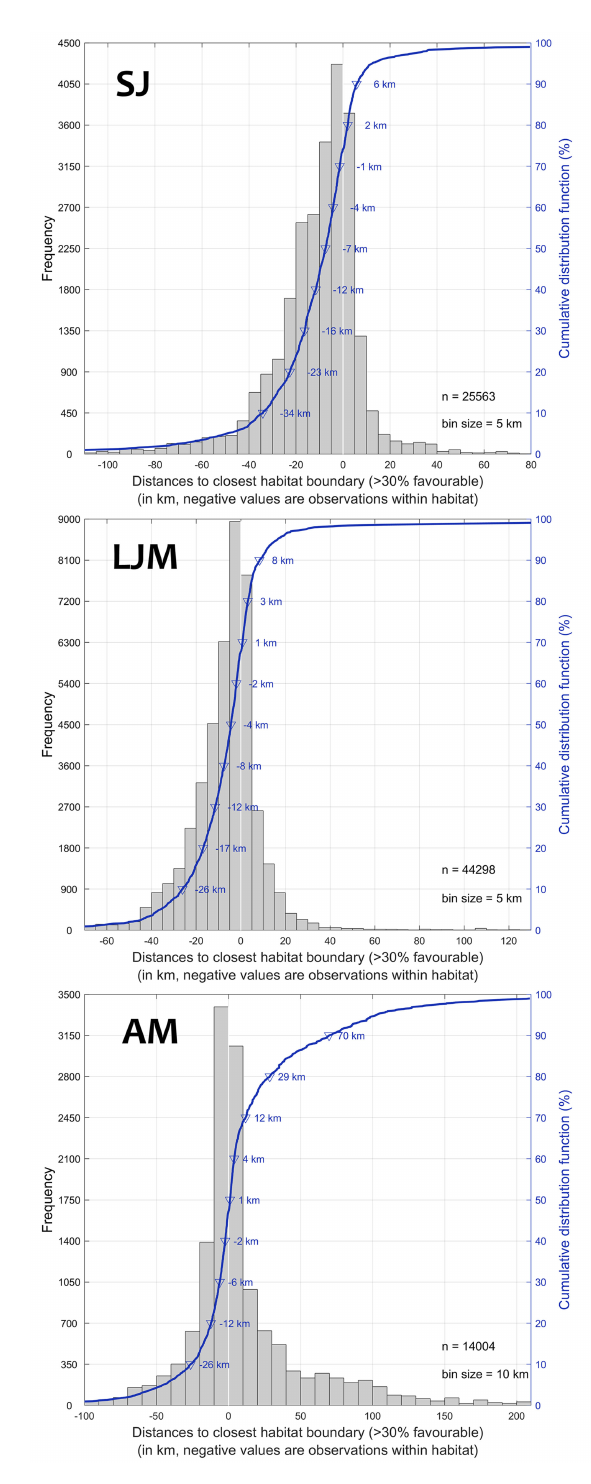
FIGURE 10 | Model performance estimated in distances (km) of validation presence data to closest core habitat boundary (above 30% favorable) for each size and sex class (SJ, LJF, LJM, AF, and AM) and corresponding cumulative distribution showing distance values for each decile bin of presence data (negative are observations within favorable habitat). For the SJ class for instance, 74% of validation presence data were within the core habitat (above 30%) and the distance of the 80 th percentile of presence data to the closest core habitat boundary was 2 km (n =